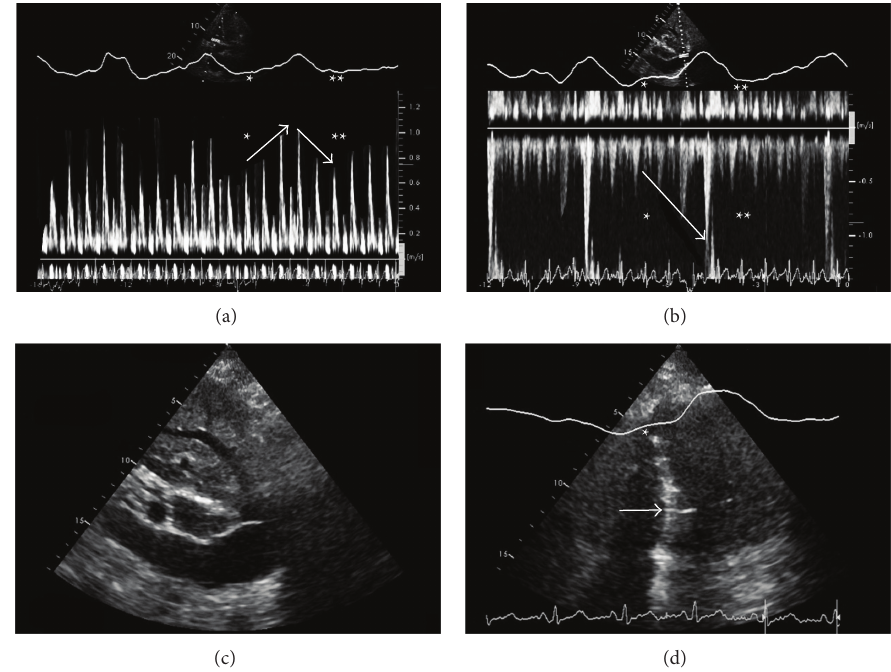
Figure 2: Echocardiographic features of constrictive pericarditis. (a) Pulse wave Doppler recording of tricuspid inflow in apical four-chamber view: increased early diastolic filling velocity during inspiration (ascending arrow), opposite during expiration (descending arrow). (b) Pulse waveDopplerrecordingofhepaticveininflowinsubcostalview:increasedvelocityduringinspiration(descendingarrow).(c)Dilatedinferior vena cava and hepatic veins with restricted respiratory variation in subcostal view. (d) Abnormal interventricular septum motion (septal bounce) as a sign of ventricular interdependence in apical four-chamber view: septal bounce to the left ventricle during inspiration